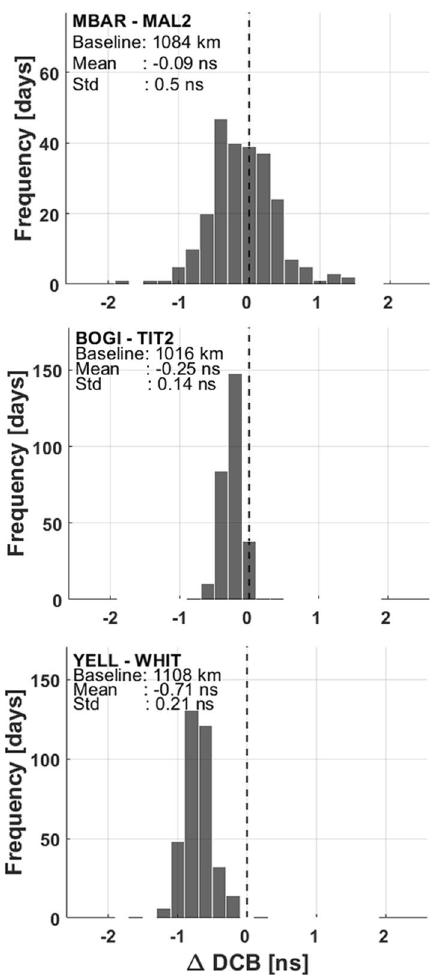
Fig. 4 Bias calculation error for shorter baseline case. The top panel is for mid-latitude and the bottom panel is for the high-latitude stations’ pair. The black dotted line in the middle of each plot shows the zero DCB error line